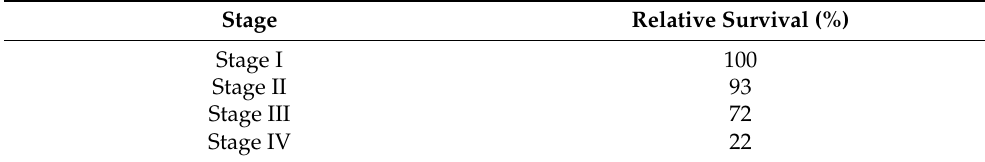
Table 1. The relative 5-year survival of breast cancer patients by stage [6].